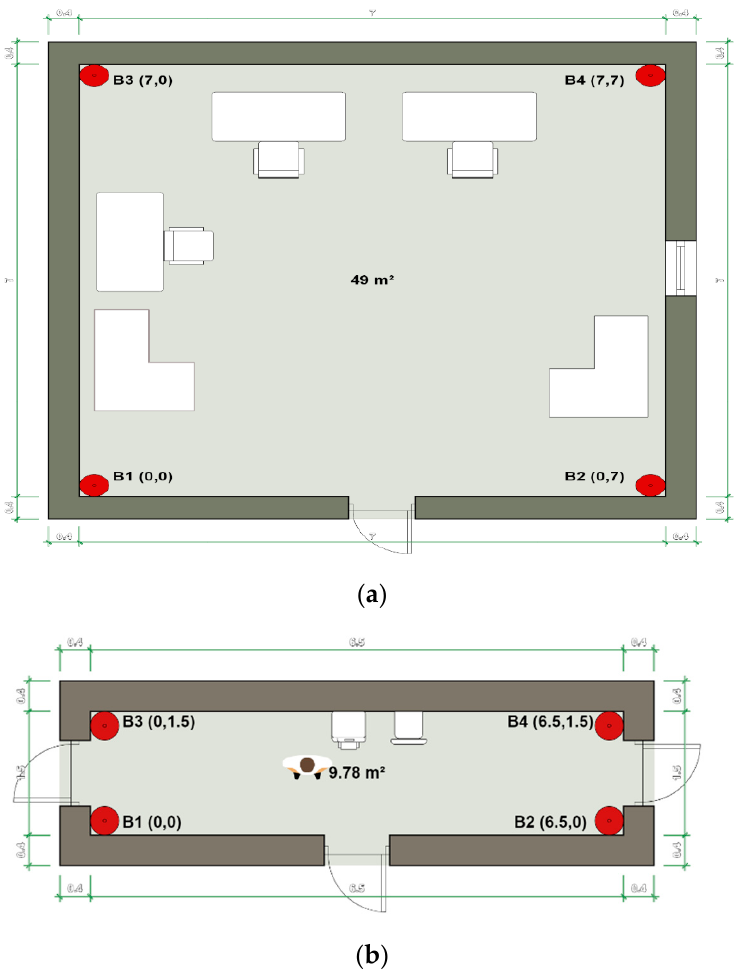
Figure 7. Experimental sites: ( a ) Office room; ( b ) Corridor.